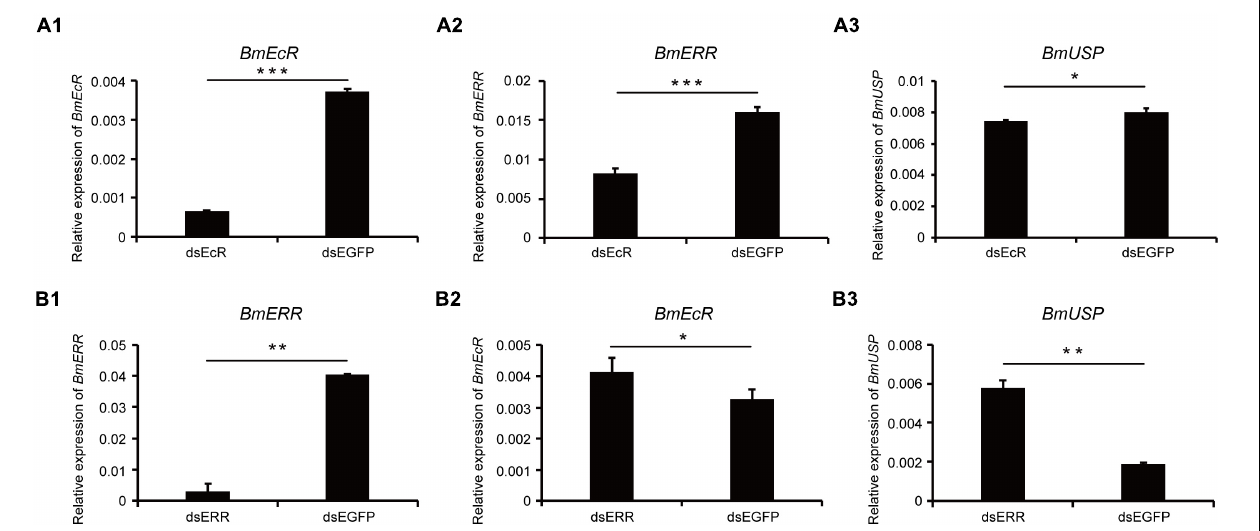
FIGURE 6 | Expression levels of Bombyx mori ERR ( BmERR ), BmEcR, and BmUSP in BmE cells after dsRNA interference. (A1–A3) Expression levels of BmERR , BmEcR, and BmUSP after treatment with dsEcR. (B1–B3) Expression levels of BmERR , BmEcR, and BmUSP after treatment with dsERR. * P < 0.05, ** P < 0.01, and *** P < 0.001; t